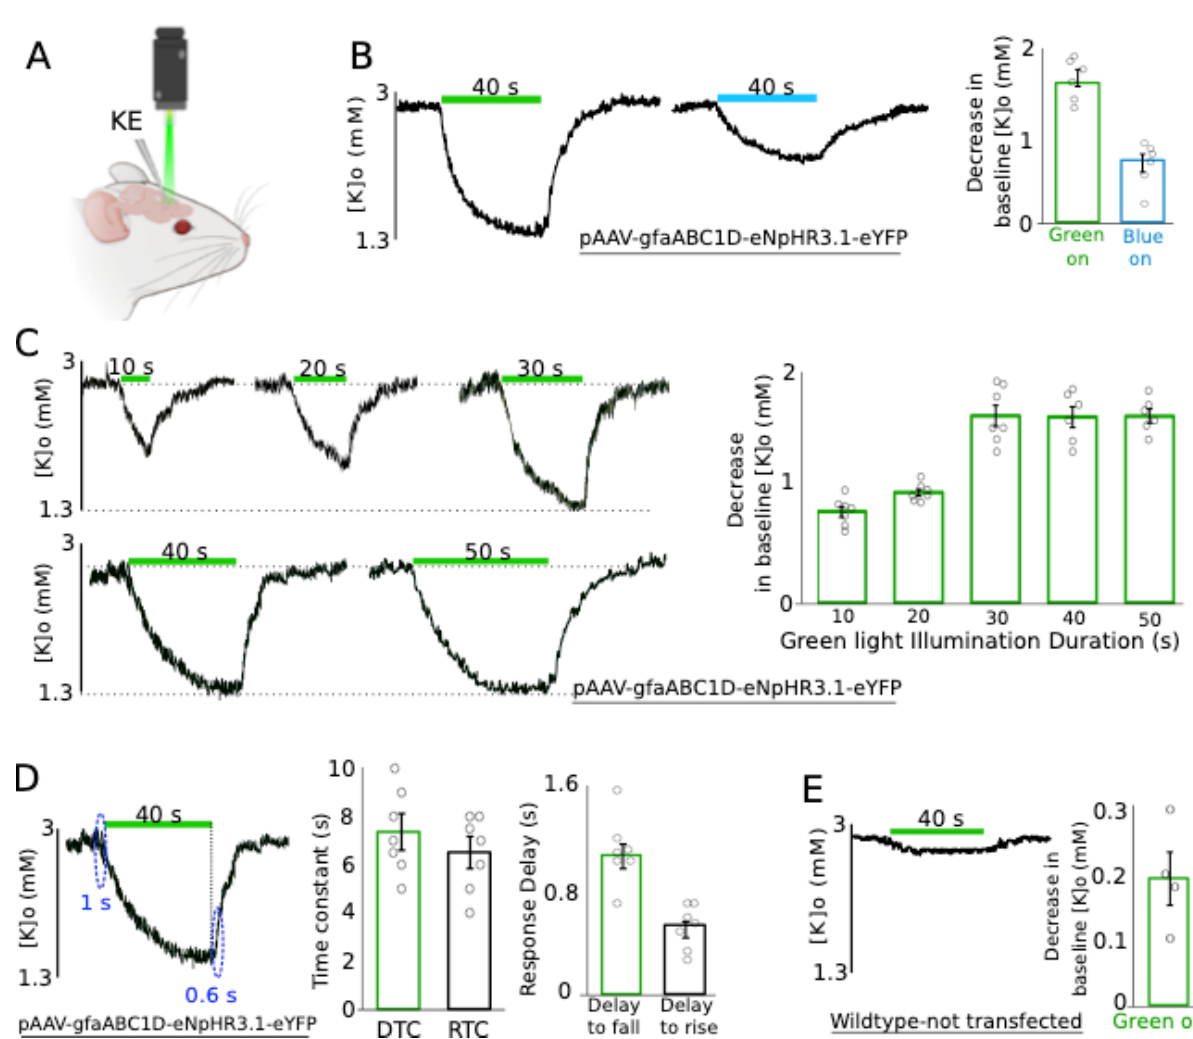
Figure 2. Green light application significantly decreased the resting [K]o in the transfected area. ( A ) An experimental configuration: 1 K-sensitive electrode (KE) was implanted in the transfected area to study the effect of green light application on [K]o. ( B ) Blue and green light with the same duration were tested on the transfected animal. Left: usage of blue light was not as effective as green light. Right: changes in the baseline [K]o amplitude following green and blue light application are summarized ( n = 6). ( C ) Effect of green light application on [K]o with 5 different exposure times. Left: A gradual decrease in the resting [K]o; a minimum 30 s exposure time was required to see the [K]o decay reaching a plateau. Right: the reductions in the baseline [K]o exposed to different light durations are summarized ( n = 7). ( D ) Middle: Decay time constant (DTC) and rise time constant (RTC) of the resting [K]o upon light application right: resting [K]o started falling/raising with a small delay (~1 s) after turning the light on/off ( n = 7). ( E ) Control group: usage of green light on wildtype untransfected mice had a negligible effect on the baseline [K]o ( n = 4). The green bar represents green light application.